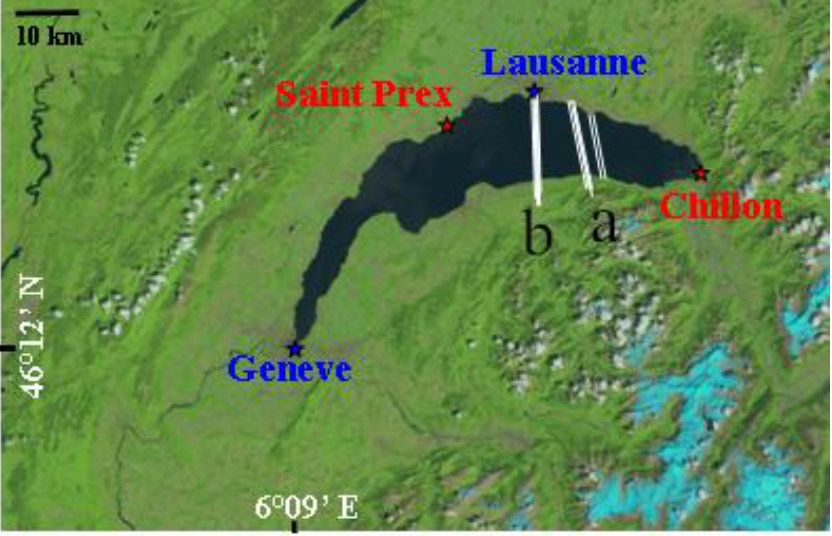
Figure 1. The Ice, Cloud and Land Elevation Satellite (ICESat) tracks through Lake Leman. (a) Ascending mode and (b) descending